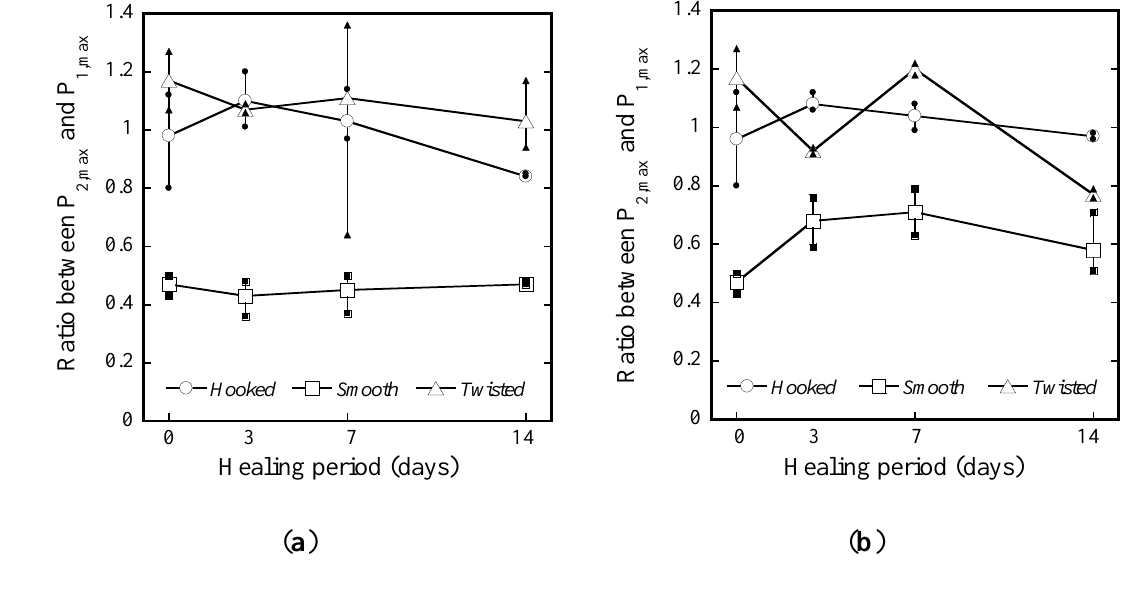
Figure 5. Ratio between P ( a ) Air; ( b )